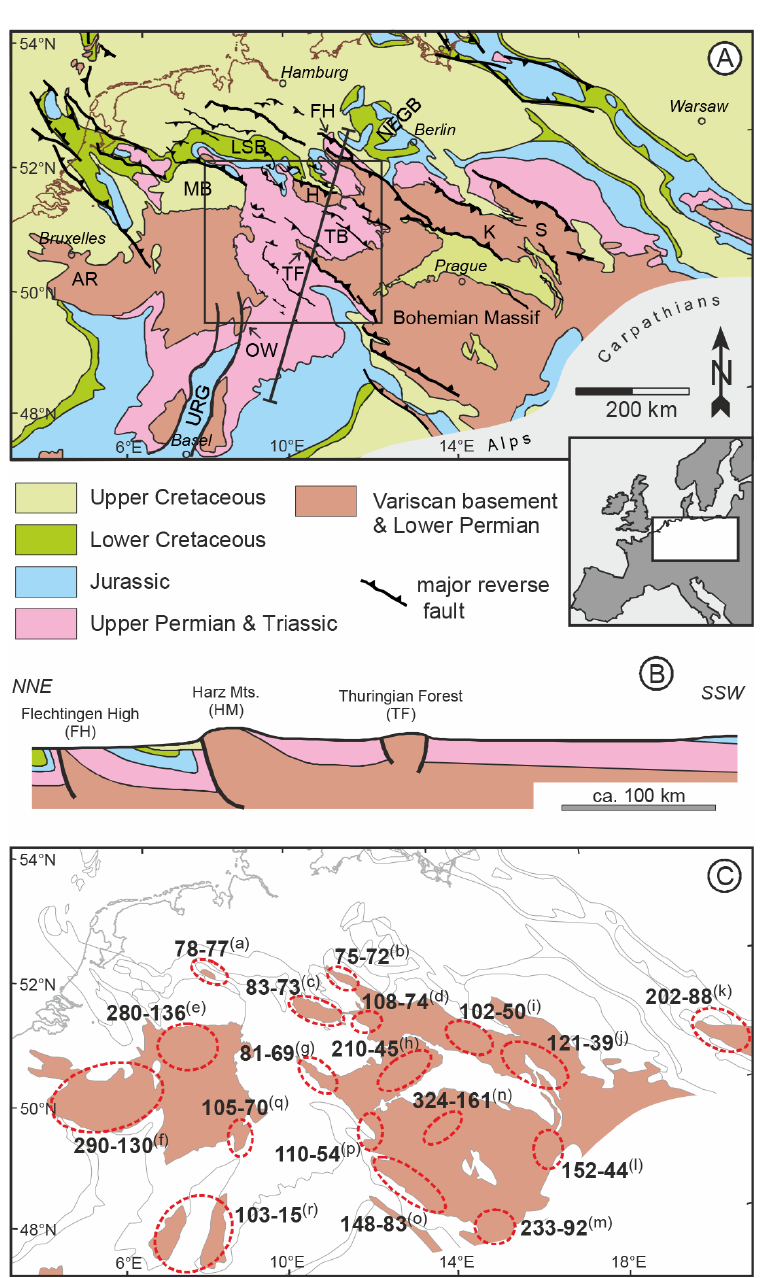
Figure 1. (a) Pre-Tertiary geological sketch map of central Europe (modified after Ziegler, 1990). The black rectangle indicates the position of the detailed geological map in Fig. 3, and the straight line indicates the trace of the section shown in (b) . The inset indicates the location within Europe. AR – Ardennes, FH – Flechtingen High, H – Harz Mountains, K – Karkonosze, NEGB – Northeast German Basin, LSB – Lower Saxony Basin, MB – Münsterland Basin, OW – Odenwald, S – Sudetes, TB – Thuringian Basin, TF – Thuringian Forest, URG – Upper Rhine Graben. (b) Simplified geological section across the central part of the study area, highlighting the major fault-bordered basement highs. For a detailed section see Fig. 4. (c) Compilation of apatite fission-track ages obtained on structural highs exposing Paleozoic rocks in central Europe. a: Ibbenbüren High, Senglaub et al. (2005); b: Flechtingen High, Fischer et al. (2012); c: Harz Mountains, von Eynatten et al. (2019); d: Halle volcanic complex, Jacobs and Breitkreuz (2003); e: Northern Rhenish Massif, Karg et al. (2005); f: Ardennes/Venn, Glasmacher et al. (1998), Xu et al. (2009) and references therein, Barbarand et al. (2018); g: Thuringian Forest, Thomson and Zeh (2000); h: Erzgebirge, Ventura and Lisker (2003), Lange et al. (2008), Wolff et al. (2015); i: Lusatian Block, Lange et al. (2008), Ventura et al. (2009); j: NE Bohemian Massif, Danisík et al. (2010, 2012), Migo´n and Danišík (2012), Sobczyk et al. (2015, 2020); k: Holy Cross Mountains, Botor et al. (2018); l: E Bohemian Massif, Botor et al. (2017); m: S Bohemian Massif, Hejl et al. (2003); n: Barrandian, central Bohemian Massif, Glasmacher et al. (2002); o: Bavarian Forest, Vamvaka et al. (2014); p: W Bohemian Massif, Hejl et al. (1997); q: Odenwald, Wagner (1968); r: Black Forest/Vosges, Timar-Geng et al. (2006), Link (2009), Dresmann et al. (2010), Meyer et al. (2010). Solid Earth, 12, 935–958, 2021